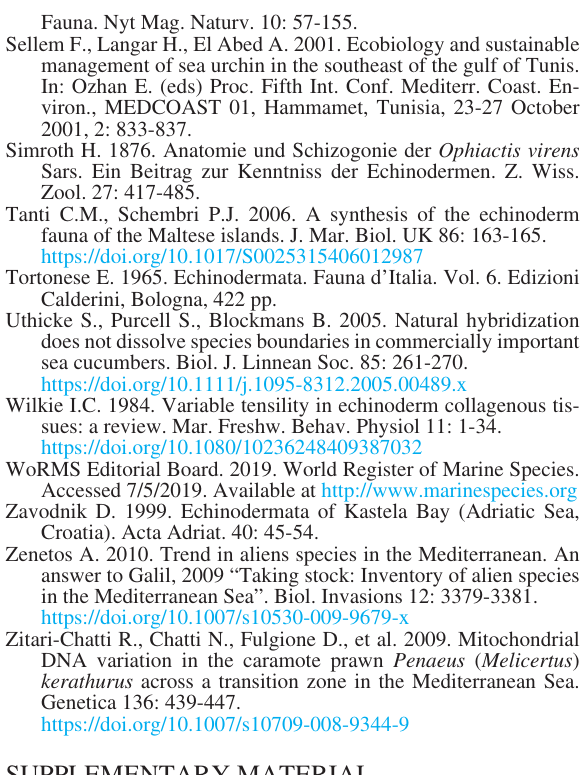
Table S1. – Collection sites and sampling methods of the echino- derms from different localities of northern Tunisia. Table S2. – Samples name’s and diameters. With the habitat type, depth (maximum and minimum) and date of collection of each